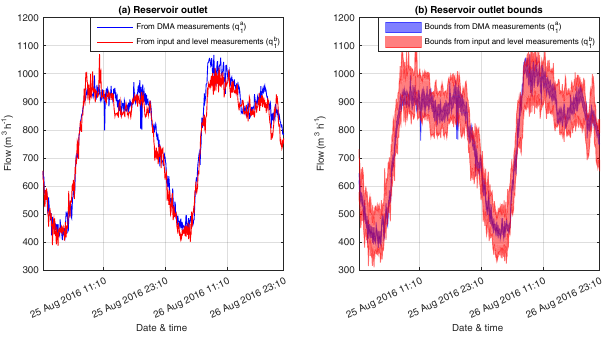
Figure 4. (a) Comparison of two estimates of the tank outflow, q a ( k ) and q b ( k ). (b) Comparison of the uncertainty bounds gen- 1 1 erated by the IHISE algorithm for the same